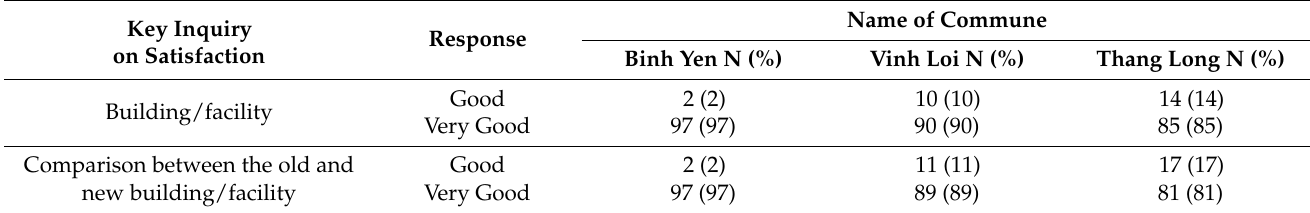
Table 4. Participants’ satisfaction with the CHS infrastructure (building/facilities).